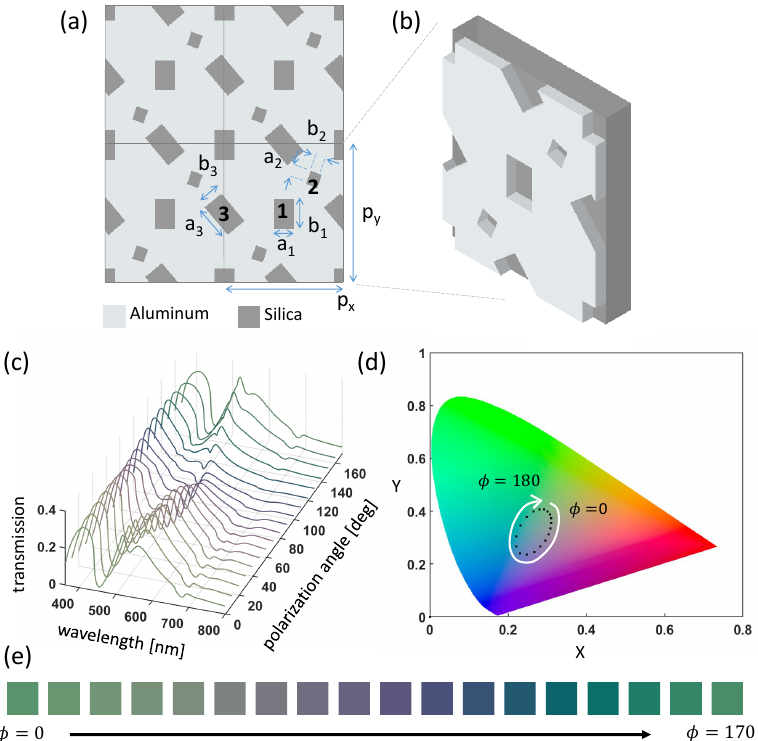
Figure 4. ( a ) Schematic of transmission type metasurface and ( b ) its unit cell. Aluminum film of thickness 40 nm on a silica substrate has three slits numbered by 1, 2 and 3, and the unit cell has two of each slit. i -th slit is tilted by φ i where a i and b i denote horizontal and vertical dimension. Geometric parameters indicated in the figure are: p x = 600 nm, p y = 700 nm, a 1 = 100 nm, a 2 = 70 nm, a 3 = 180 nm, b 1 = 150 nm, b 2 = 60 nm, b 3 = 110 nm, φ 1 = 0 ◦ , φ 2 = 70 ◦ , φ 3 = 130 ◦ . ( c ) Polarization dependent transmission spectrum. ( d ) CIE 1931 chromaticity diagram and ( e ) color palette of transmission type